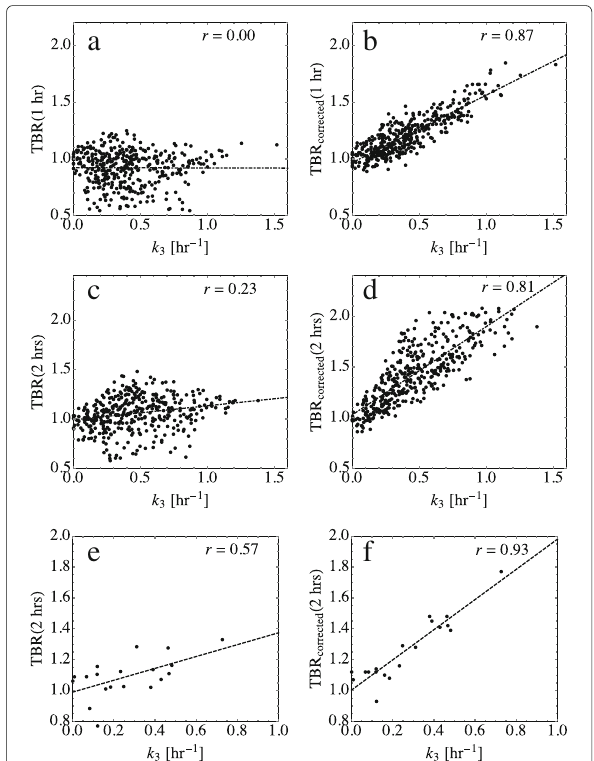
Fig. 1 Correlations between tumour-to-blood uptake ratios and the trapping rate are enhanced when uptake is corrected for the distribution volume. Left side: tumour-to-blood uptake ratio of FAZA versus trapping rate; right: tumour-to-blood uptake ratio corrected for the distribution volume versus trapping rate. a and b voxel-scale values for a representative patient tumour (pt. 2) using TAC 1 . c and d same as a and b but with TAC 2 . e and f Tumour-scale values using TAC 2 for all 20 tumours. Pearson correlation coefficients are